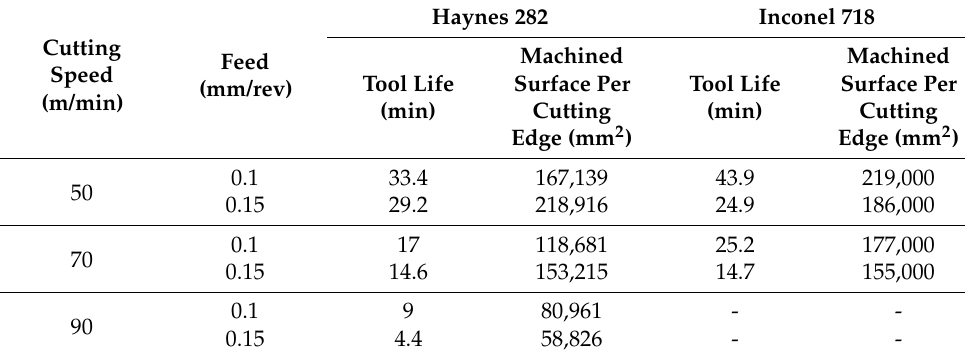
Table 5. Tool life in terms of cutting time (min) and S edge (machined surface per edge (mm 2 )) in the turning of Inconel 718 [38] and Haynes 282 [36] with conventional pressure